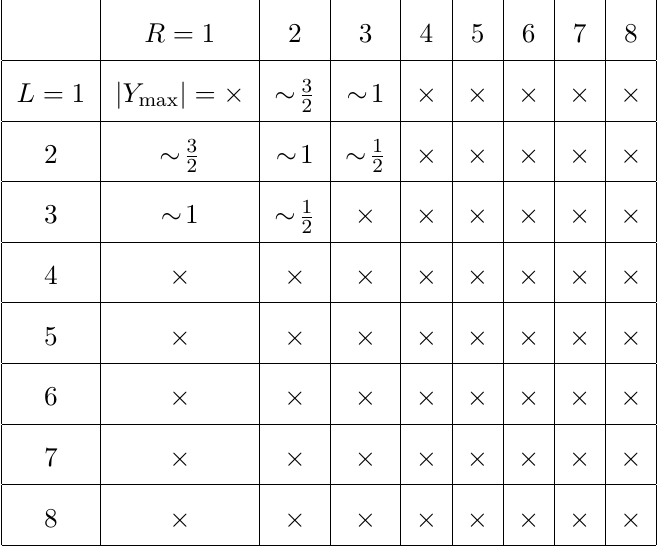
Table 10 . The representations and corresponding fields for the vector-like fermion BSM Loryons still viable after considering constraints on S . A ∼ means the representation is not viable on its own but can be added together with other BSM representations to flip the sign of κ